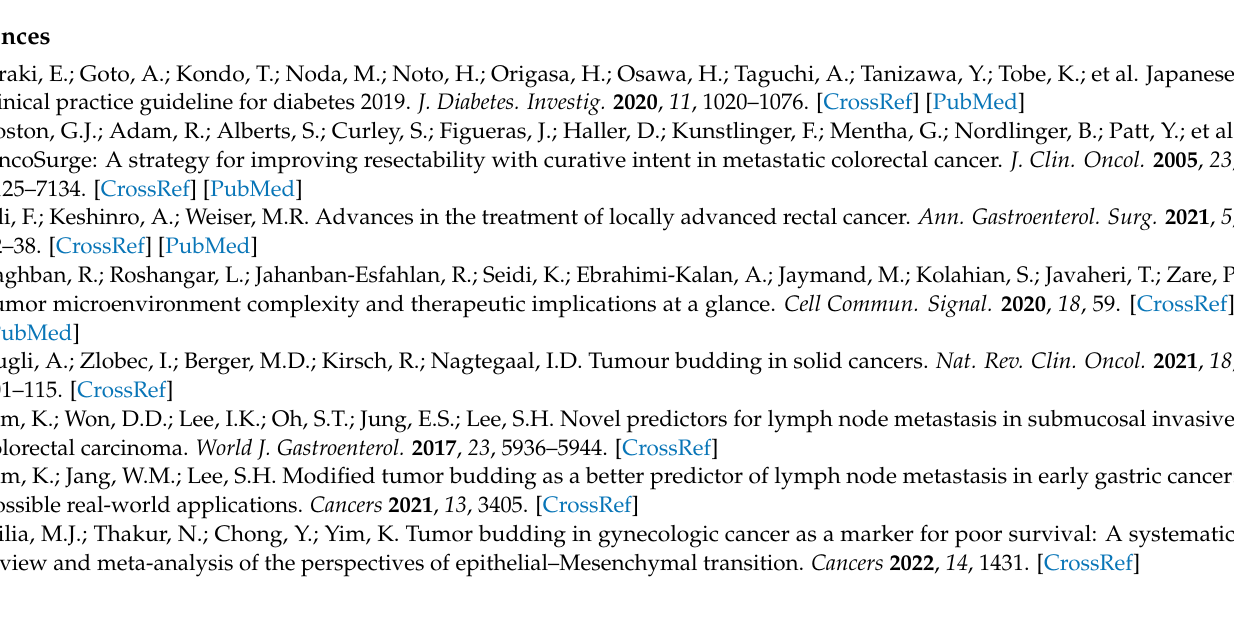
Table S4: Associations between ITB, DR, and KM in PBSs and various clinicopathological features in the subgroup of colorectal cancer patients who received chemotherapy; Table S5: The prognostic significances of the TME factors, such as ITB, DR, TSR, and KM grade in PBSs using the Kaplan–Meier curve analysis in two subgroups (CCRT vs. CTx); Table S6: Multivariate Cox proportional hazards analysis of predictors for CSS in the CCRT